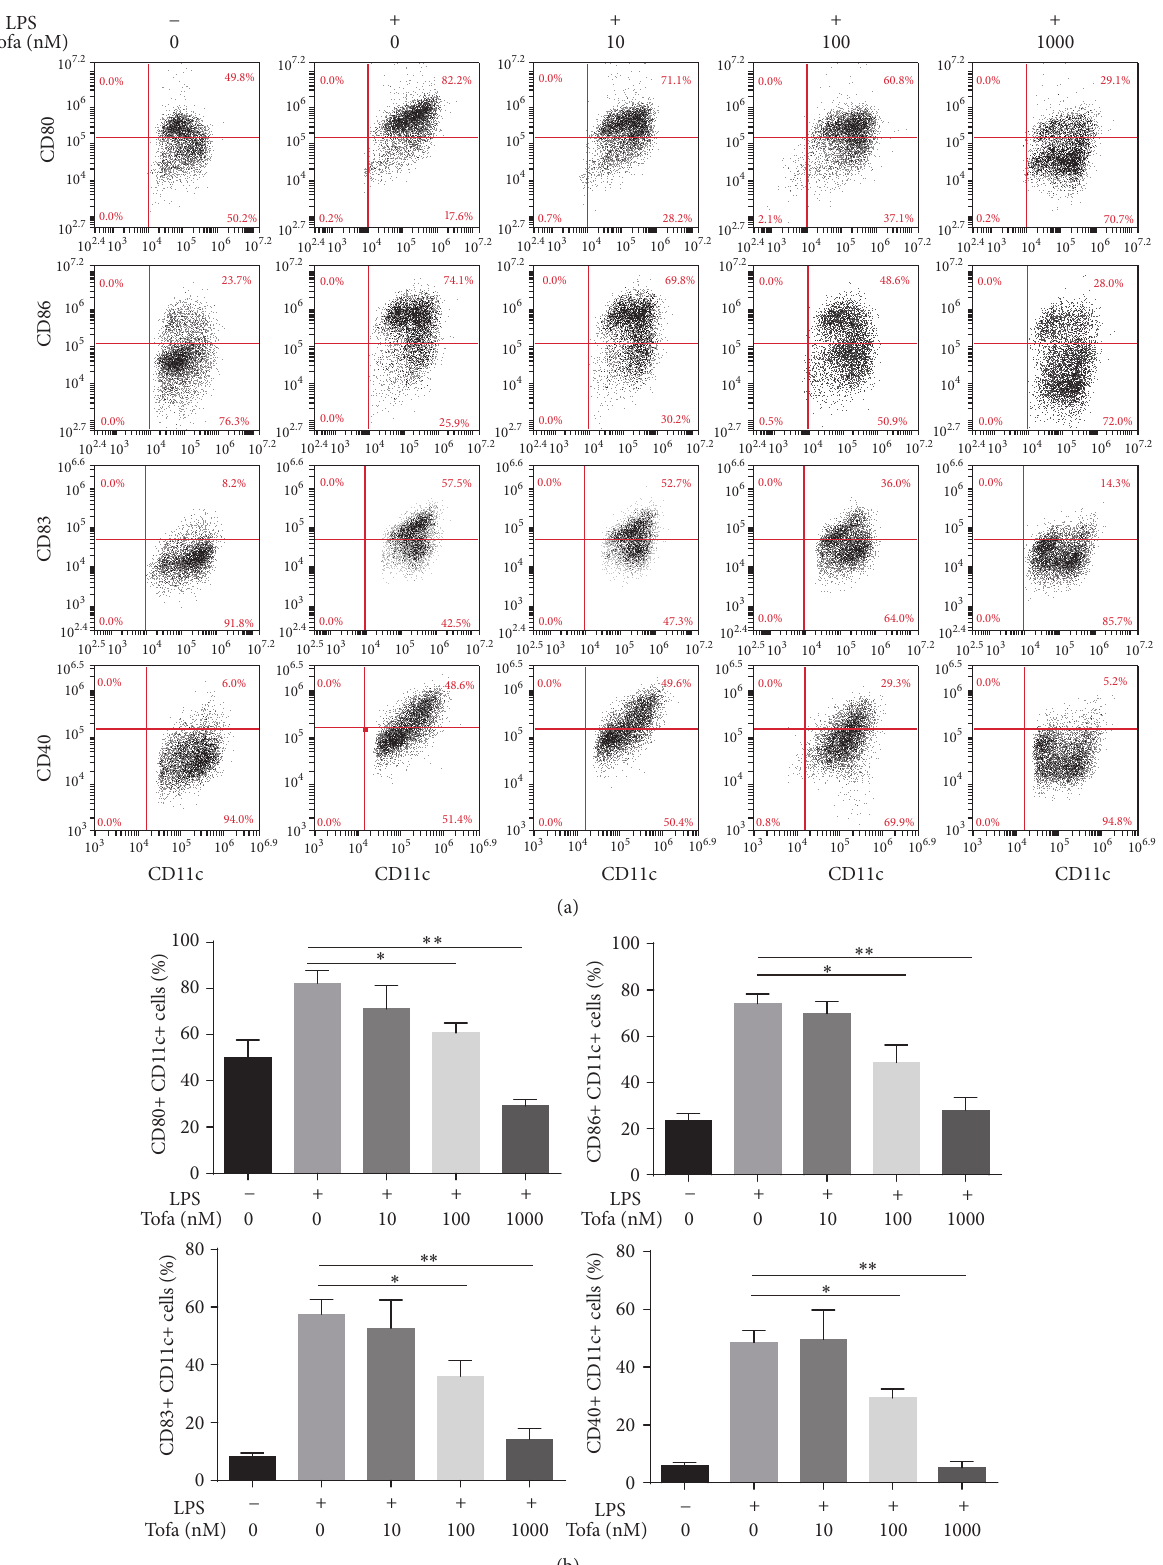
Figure 1: Analysis of Tofa-DCs surface phenotype by flow cytometry. (a) Tofa-pretreated DCs were cultured in the presence or in the absence of LPS (100ng/mL) for 24 hours. Surface expressions of CD11c, CD83, CD40, CD80, and CD86 on DCs were analyzed by flow cytometry. (b) The frequencies of CD83, CD40, CD80, or CD86 positive cells were determined. The representative results of three independent experiments with similar findings are shown. Statistical testing was performed using the Mann-Whitney test. Data are means ± SEM, ∗ 𝑃 < 0.05 , and ∗∗ 𝑃 < 0.01